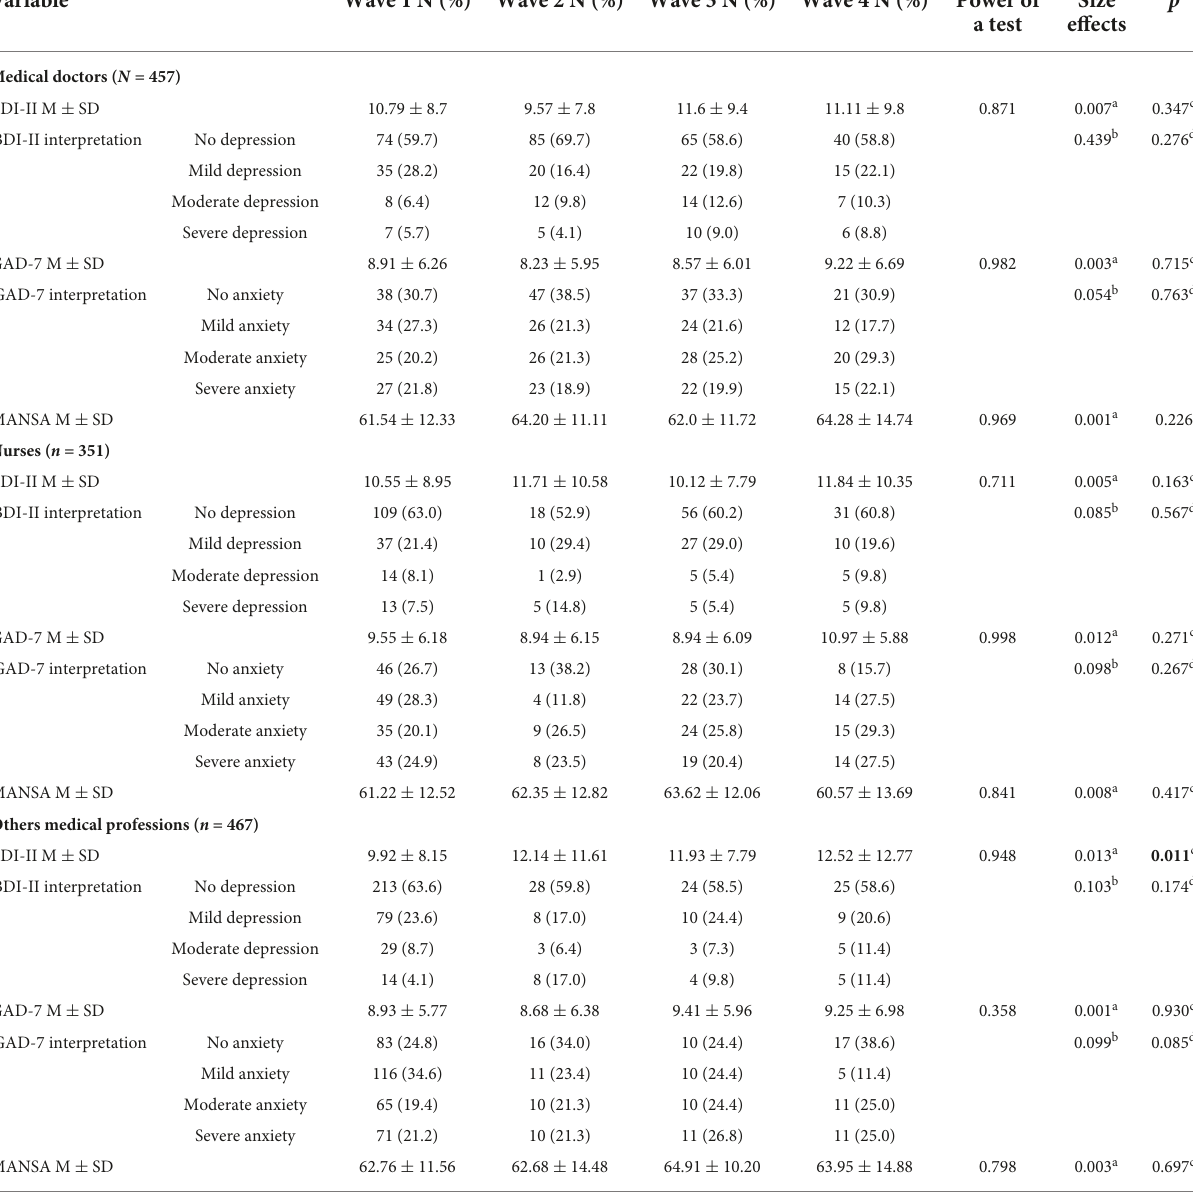
TABLE 3 Comparison of the BDI-II, GAD-7, and MANSA scales in relation to the different stages of the study for each medical profession.